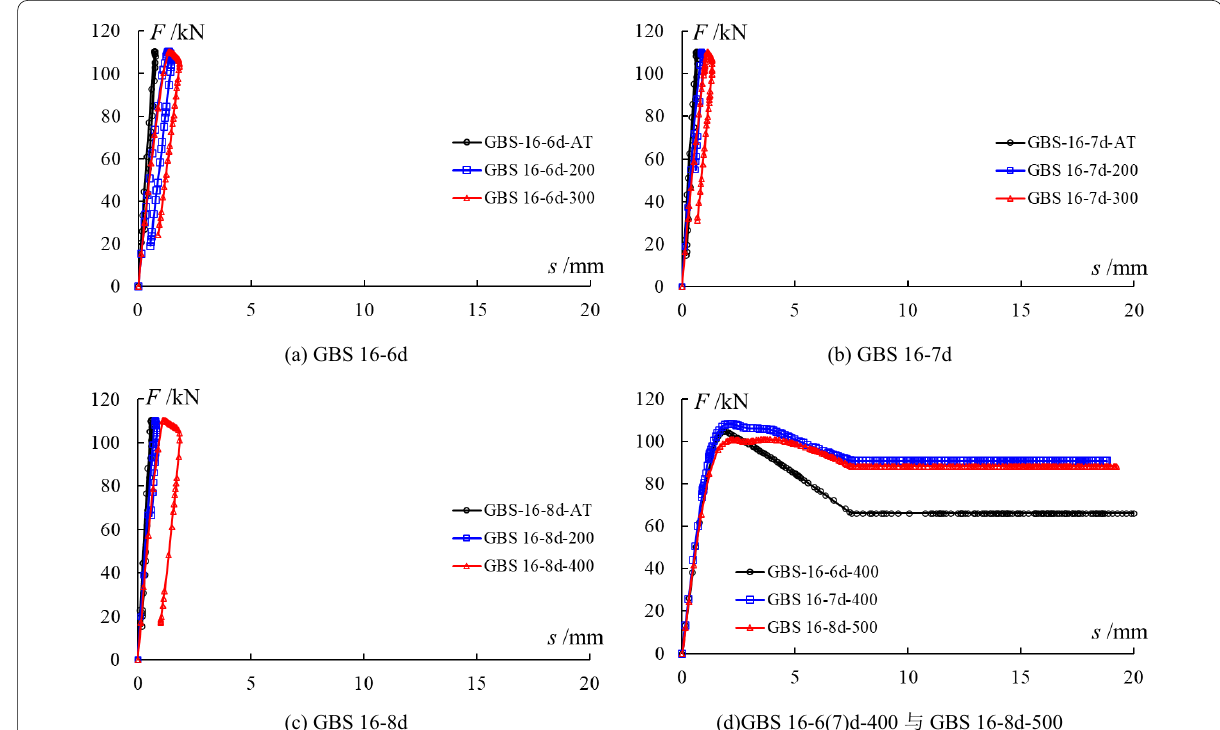
Fig. 13 F – s curves of simulation